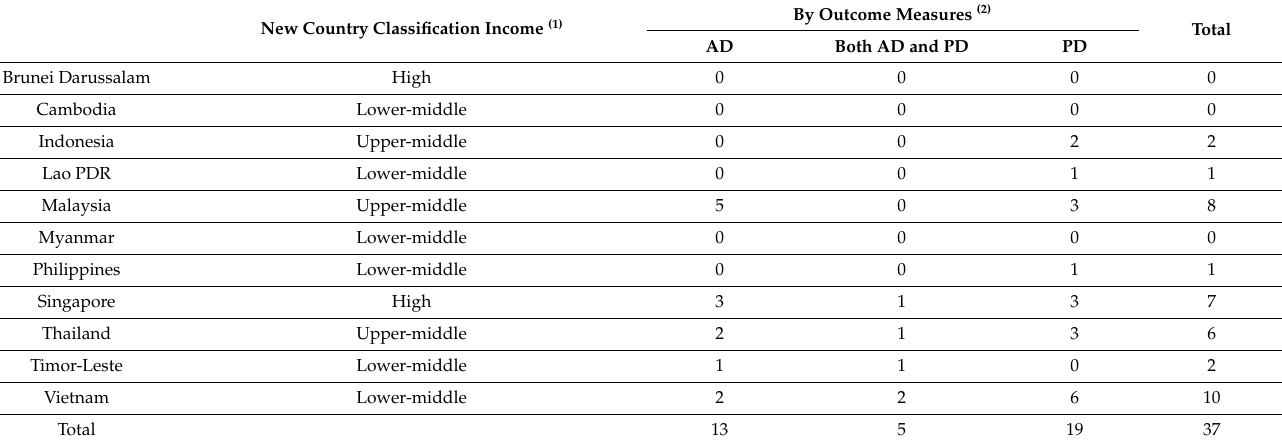
Table 2. Number of studies by outcome